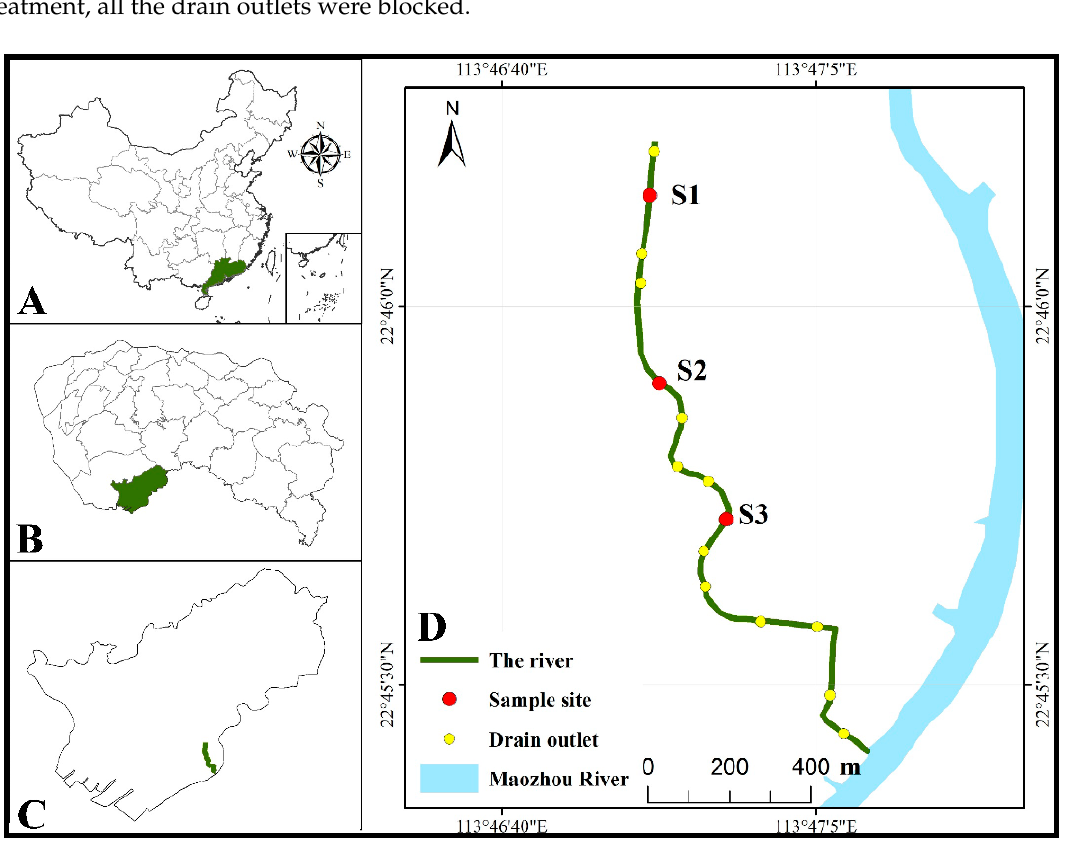
Figure 1. The location of Dongguan City in China ( A ), the location of Changan Town in Dongguan City ( B ), the location of the river in Changan Town ( C ), and the sampling sites of this study ( D ).